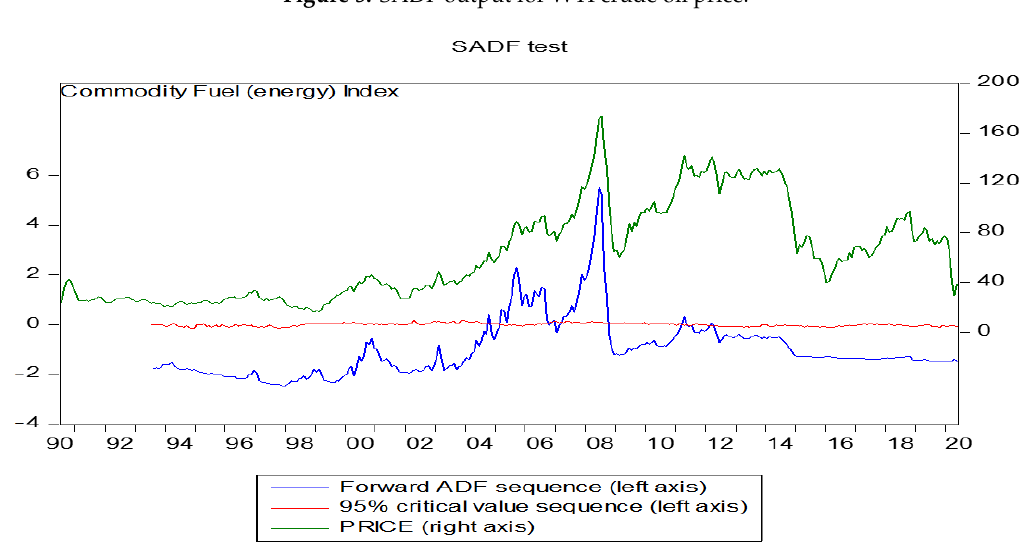
Figure 5. SADF output for WTI crude oil price.